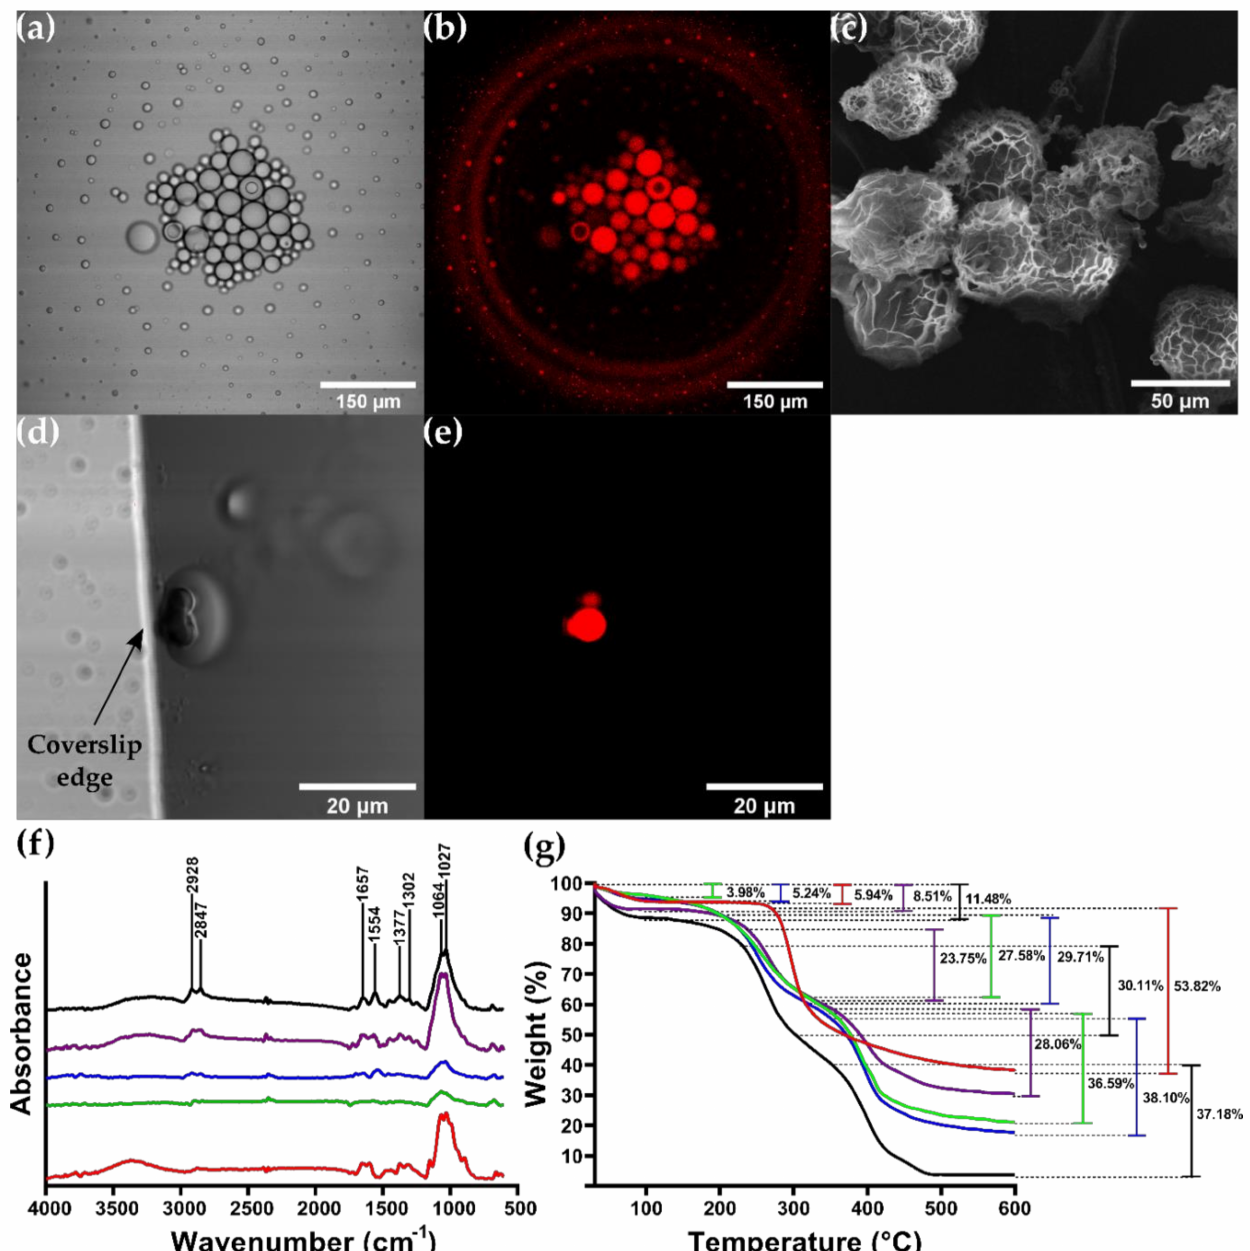
Figure 7. CSMPs size, shape and morphology characterization and encapsultes observation. ( a , b ) CLSM images of BUF-II-CSMPs-RhodB confirm micro size and sucessful labeling, respectively. ( c ) SEM image of CSMPs. ( d , e ) CLSM images of BUF-II-CSMPs-RhodB—GUVs encapsulates. ( f ) FTIR spectra of CS (red), CSMPs (green), BUF-II-CSMPs (blue), CSMPs-RhodB (purple) and BUF-II-CSMPs-RhodB (black) confirm surface modifications and main peaks of imine bonds (1554 cm − 1 ) and amide I bands (1650 cm − 1 ). ( g ) TGA thermograms of CS (red), CSMPs (green), BUF-II-CSMPs (blue), CSMPs-RhodB (purple) and BUF-II-CSMPs-RhodB (black) showed a first weight loss step (3.98 to 11.48%) that represents the dehydration of the samples. A second weight loss step (23.75 to 53.82%) due to the depolymerization of chitosan backbone chain and the degradation of the glycosidic bond in the case of CS. The final weight loss step (28.06 to 37.18%) is attributed to the degradation of glutaraldehyde and detachment of BUF-II and Rhod-B from the MPs